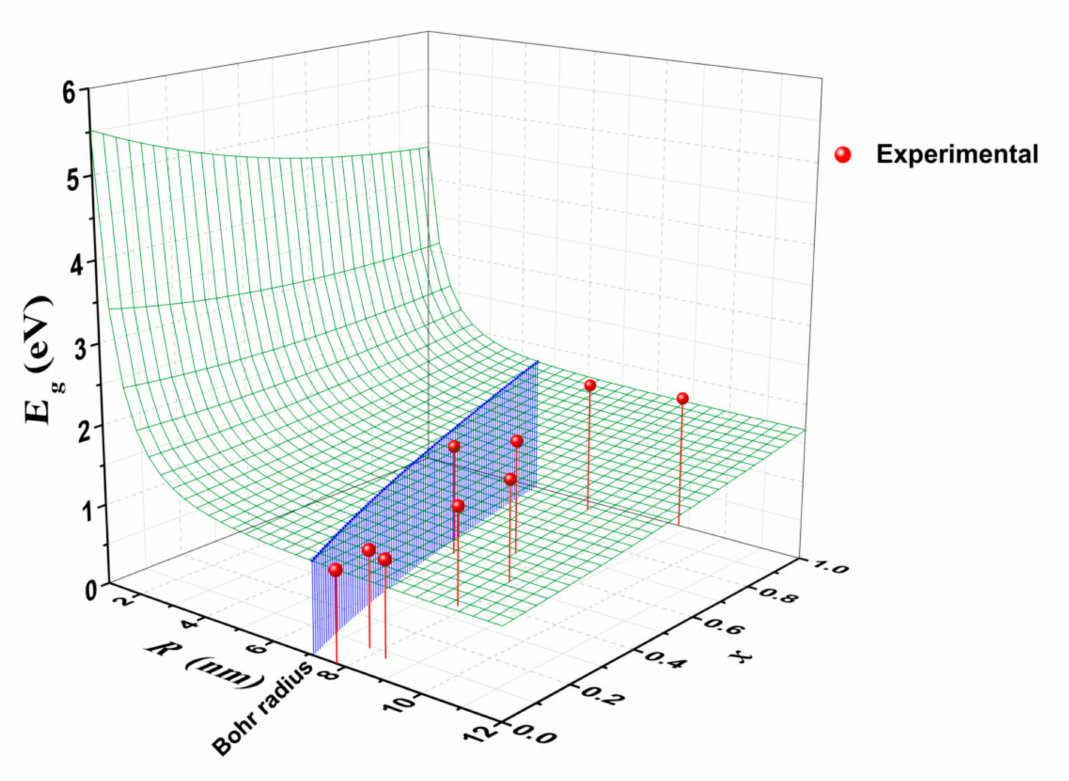
Figure 5. Band gap energy of CuIn 1 − x Ga x Se 2 nanocrystals as a function of x and R